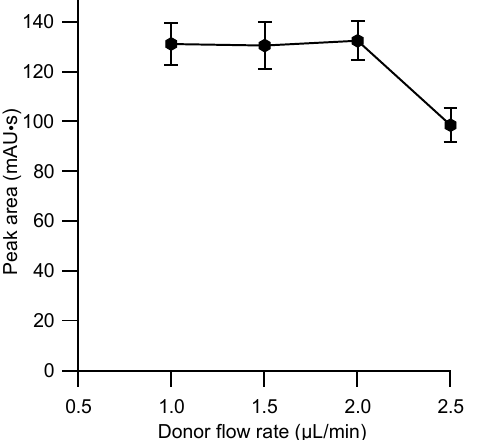
Figure 4. Effect of donor background flow rate on the extraction efficiency of naproxen. Membrane: CTA 7.5 mg, NPOE 5 mg, Aliquat 336 7.5 mg. Other conditions as for Figure 3. Each data point represents the mean value for five measurements.